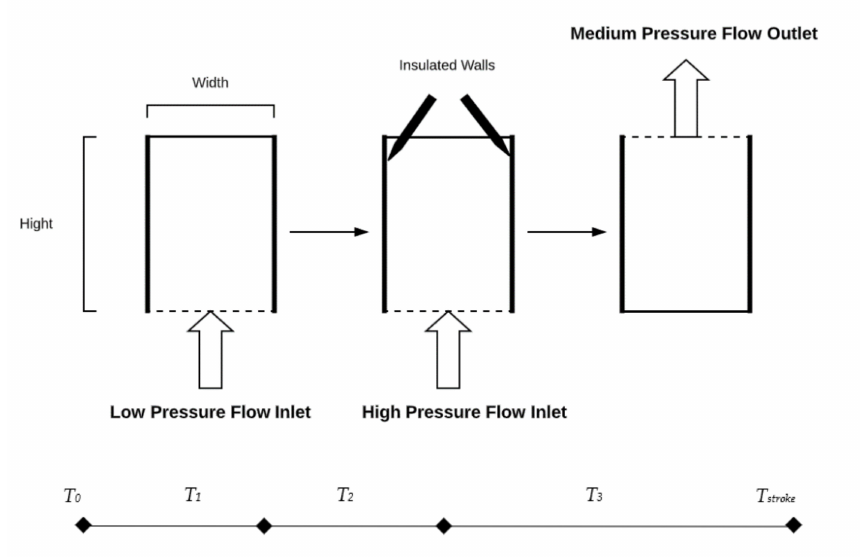
Figure 4. Schematic of the 2D model.